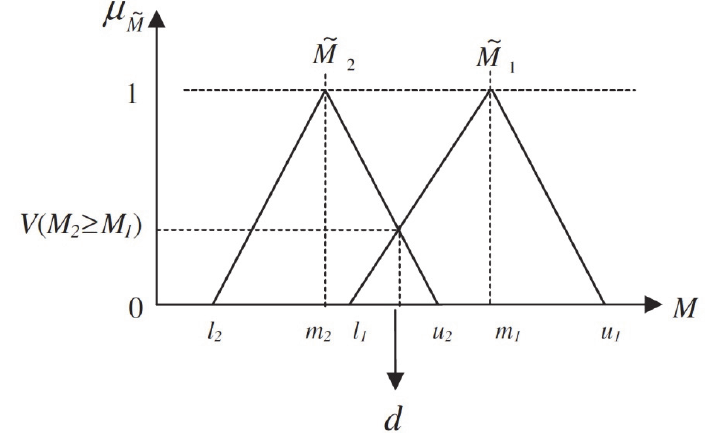
Fig. 4. The intersection between M